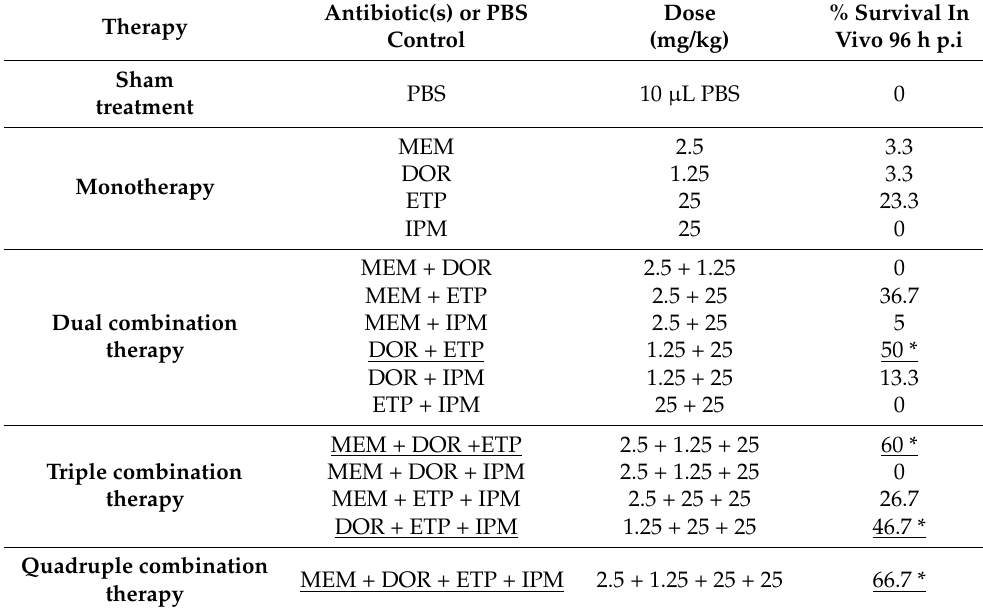
Table 2. Screen of the efficacy of 6 dual, 4 triple and 1 quadruple carbapenem combination treatments against G. mellonella larvae infected with a lethal dose of P. aeruginosa NCTC13437. One dose of each monotherapy, dual, triple, or quadruple combination was administered 2 h post-infection (p.i) and survival measured 96 h p.i. * indicates significantly enhanced survival compared to PBS treatment ( p < 0.05, log-rank test). Most potent combinations are underlined. n = 30. Antibiotic(s) or PBS Dose % Survival In Therapy Control (mg/kg) Vivo 96 h